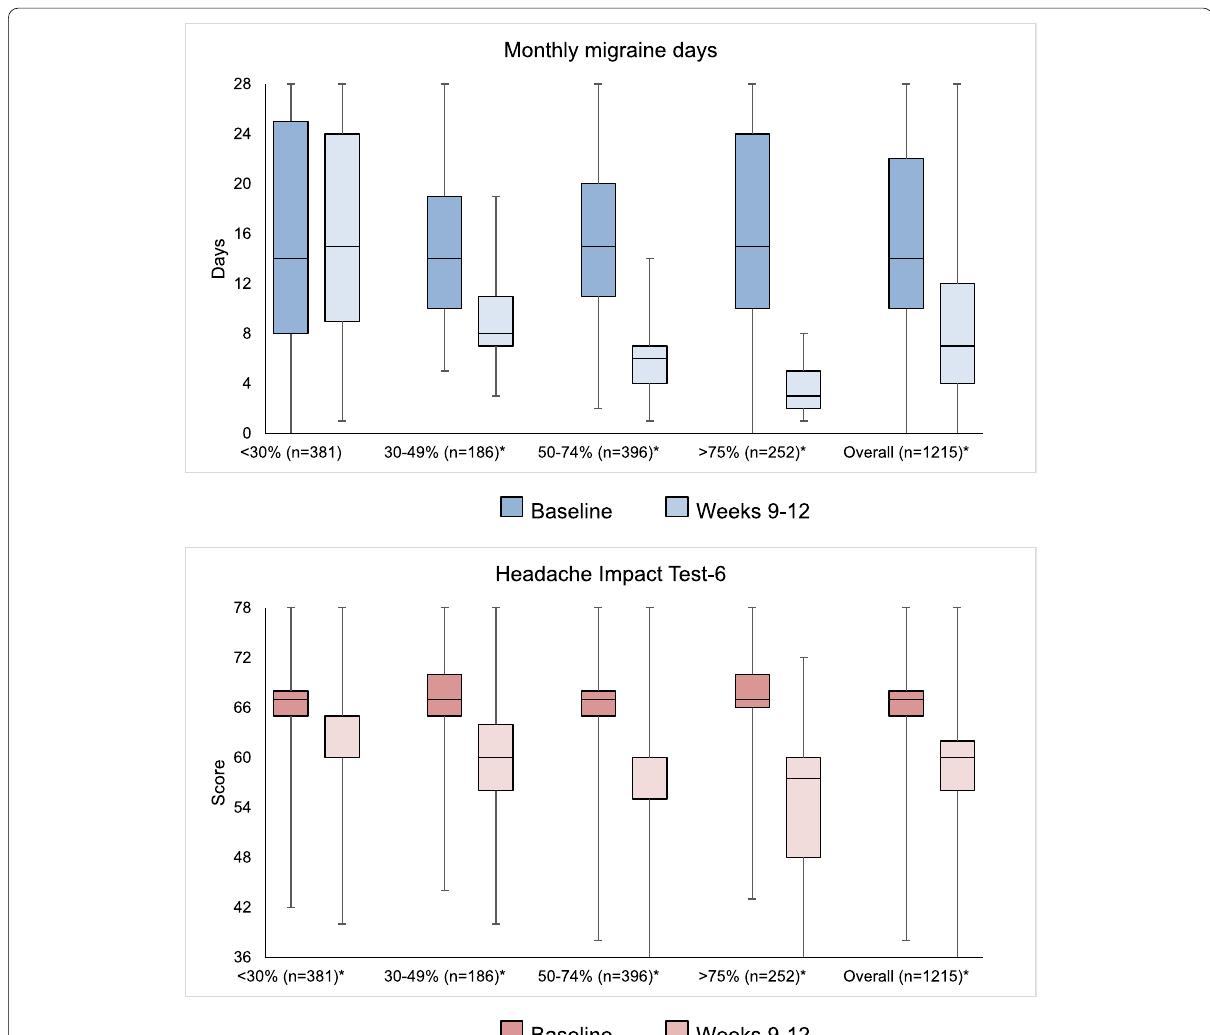
Fig. 2 Box plots showing the change in monthly migraine days (above) and HIT-6 scores (below) from baseline to weeks 9-12 of treatment with